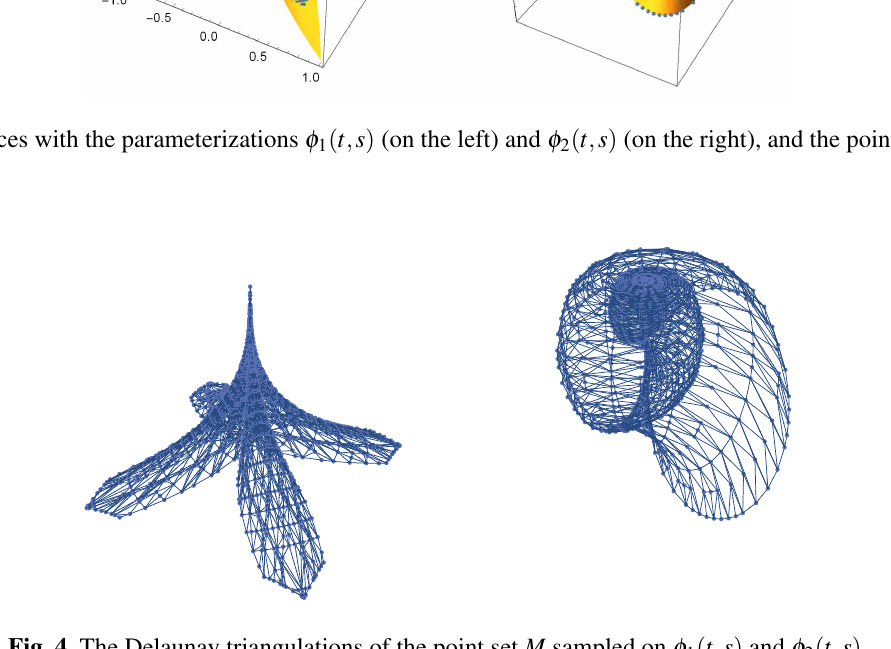
Fig. 4 The Delaunay triangulations of the point set M sampled on φ 1 ( t , s ) and φ 2 ( t , s )